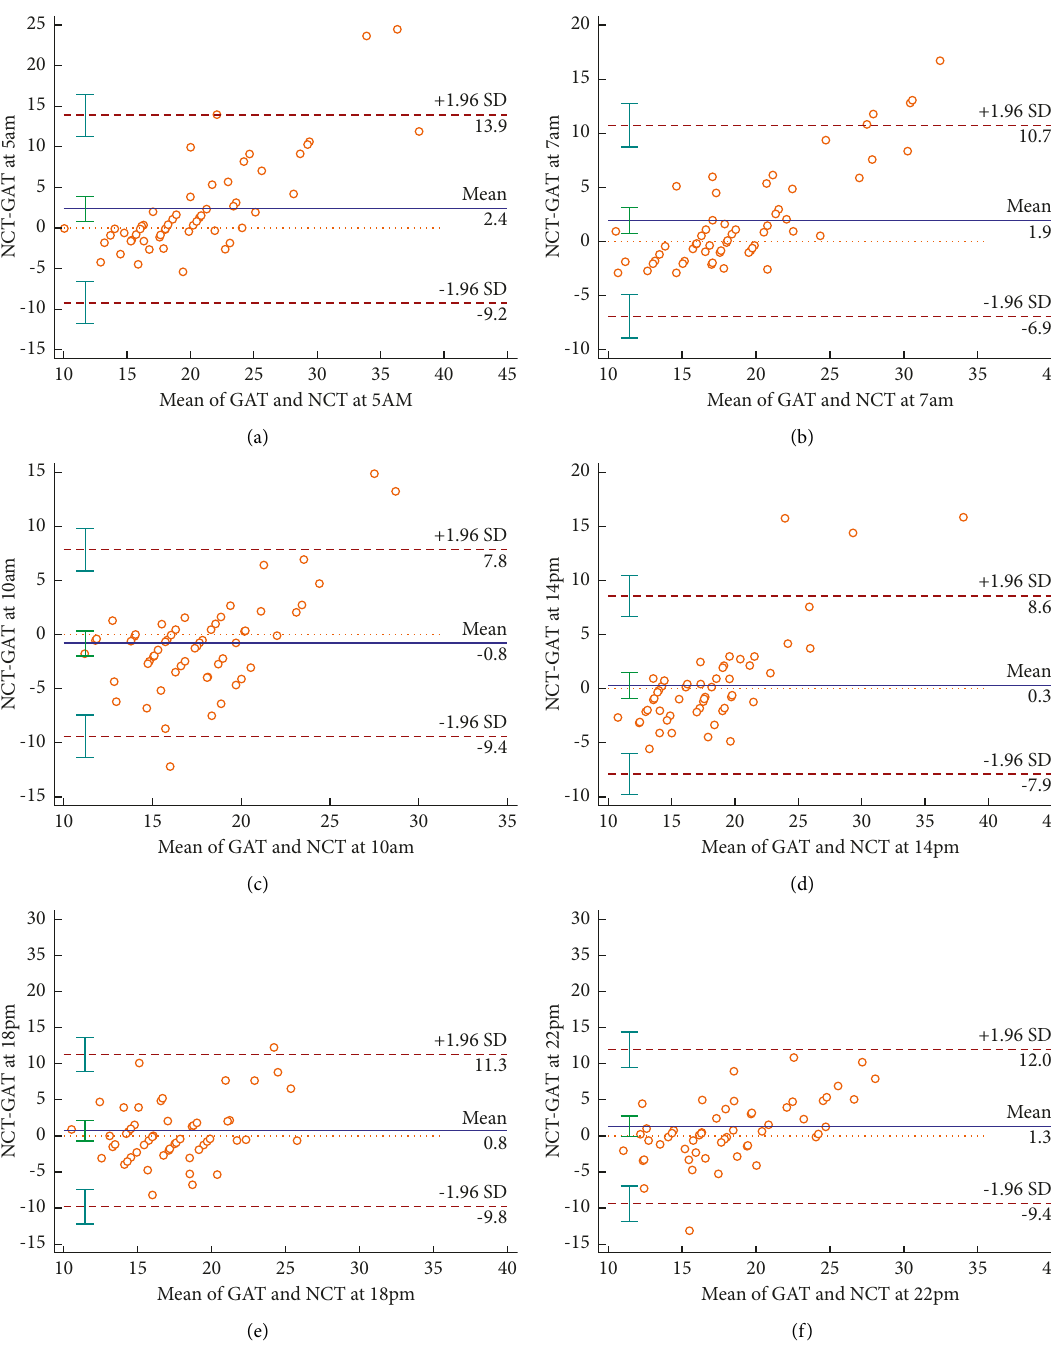
Figure 2: (a)–(f). Bland–Altman’s analysis of IOP at every time point between NCT and